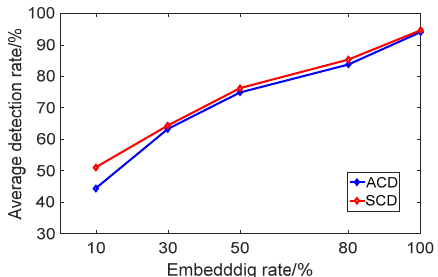
Figure 8. Average detection rate with different embedding rates.